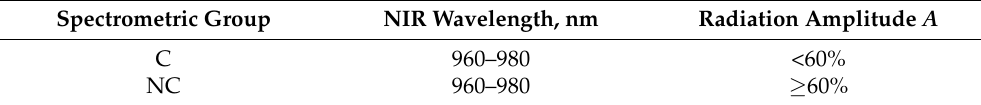
Table 1. Detection criteria for Scots pine seeds’ NIR grading using an NIR spectrometer.